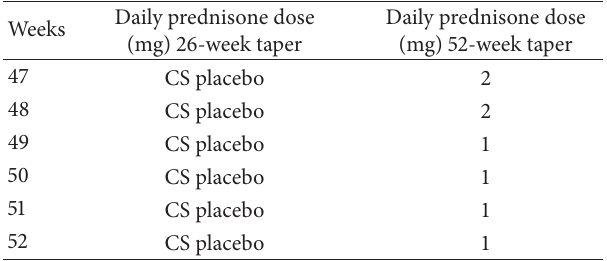
Table 3: Standardized prednisone-taper protocols during